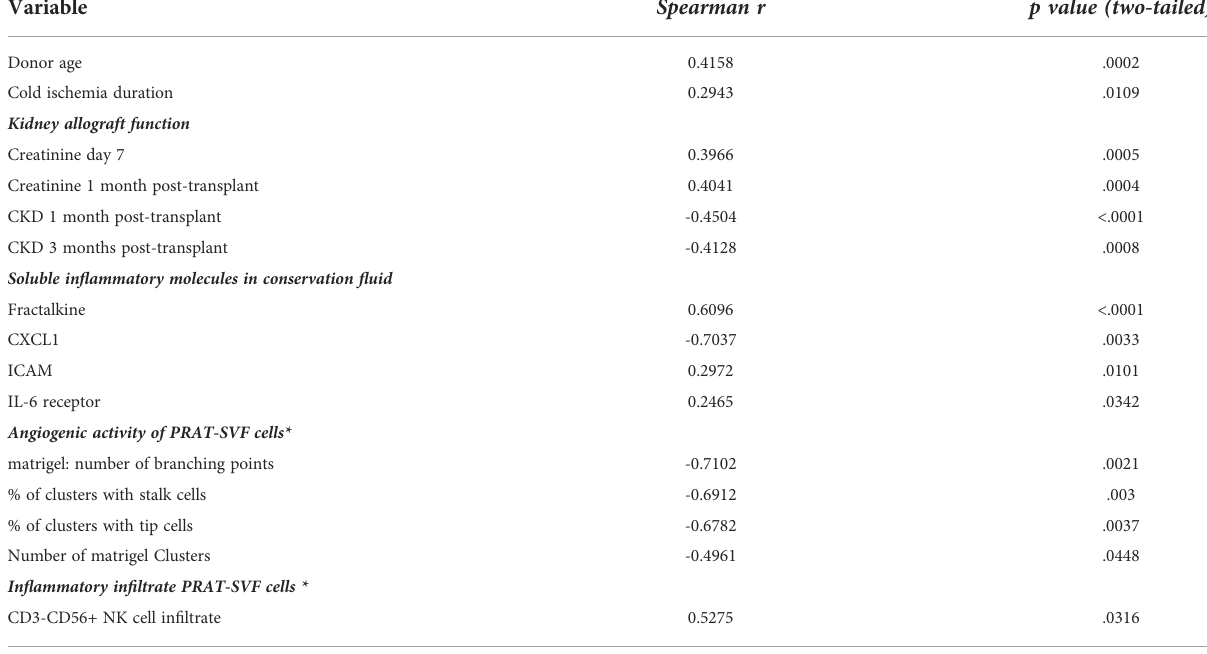
TABLE 2 Correlation observed between sVCAM levels and other in fl ammatory biomarkers in the entire cohort. Variable Spearman r p value (two-tailed) Donor age 0.4158